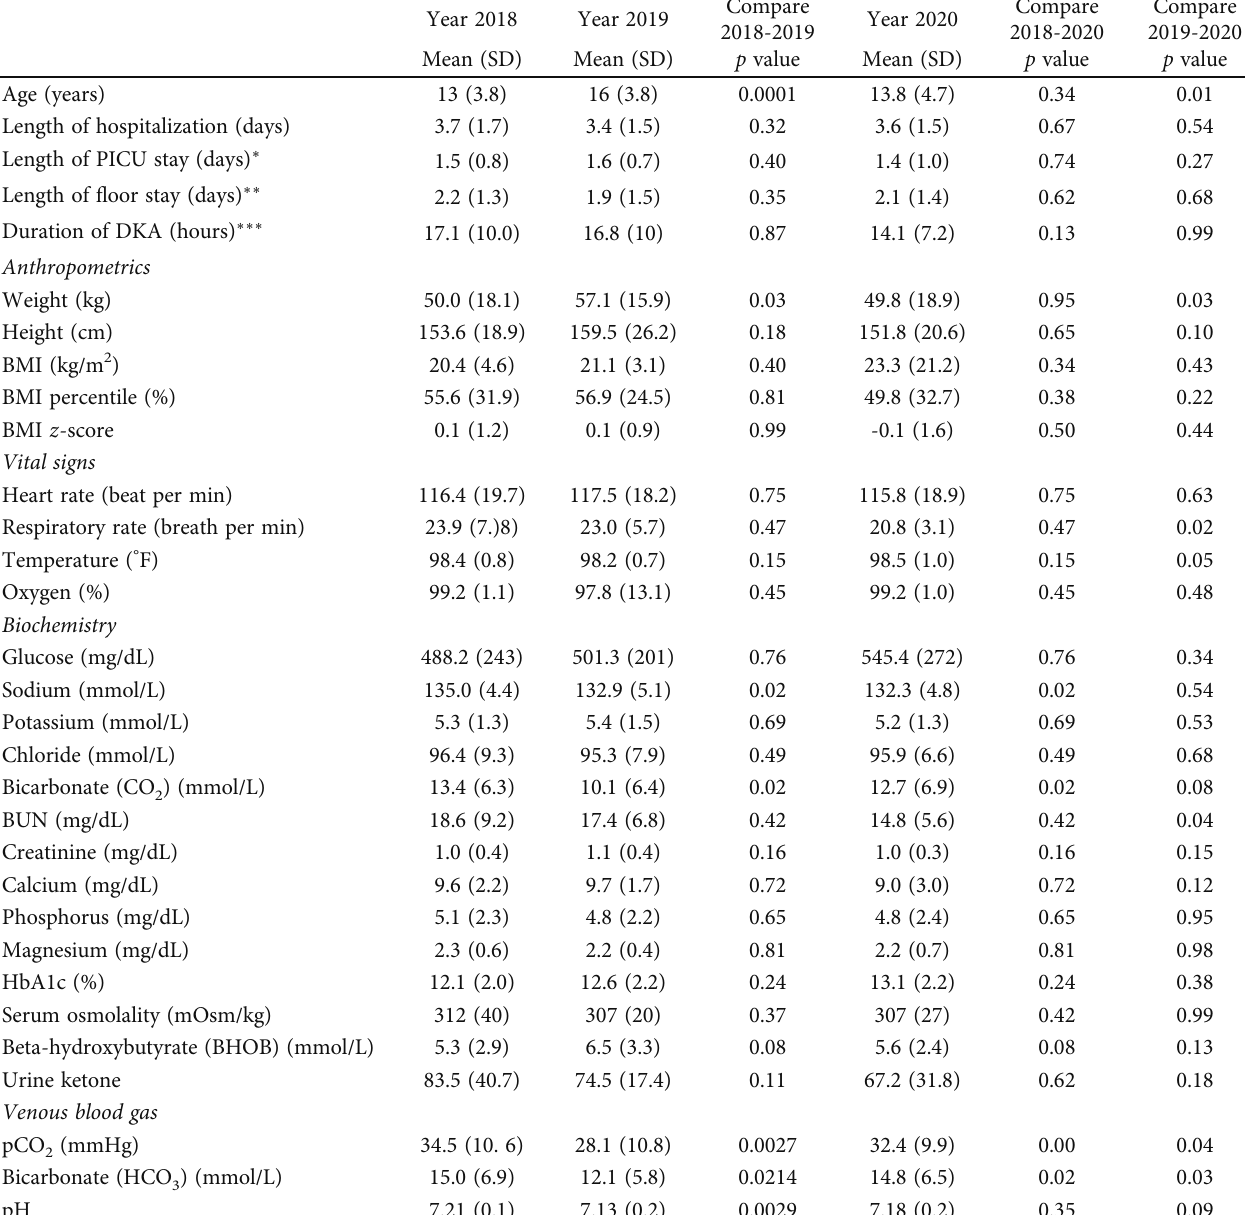
Table 3: Clinical characteristics of children and adolescents with type 1 diabetes mellitus admitted during COVID-19